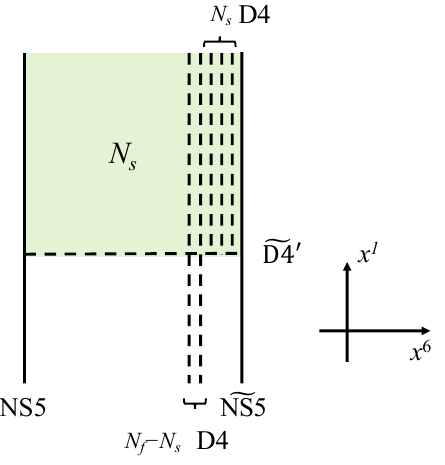
Figure 1 . The B-type Dirichlet boundary conditions for the U( N s ) vector multiplet coupled to N f chiral multiplets with singularity realized by the f D4 and N s of N f D4-branes